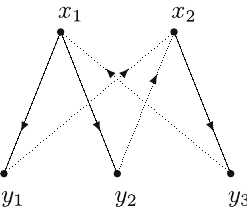
Figure 4: An arc - coloured bipartite tournament with